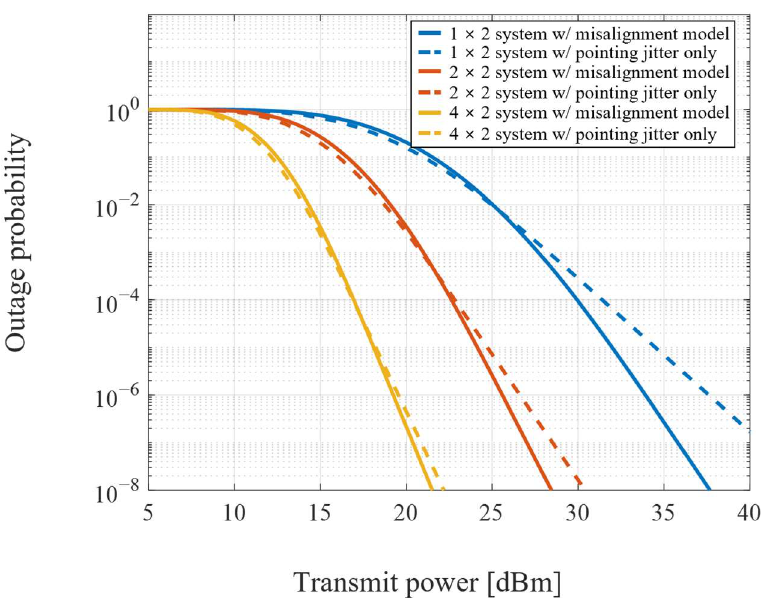
Figure 5. Outage performance of M × N systems for data reception at the UAV terminal.